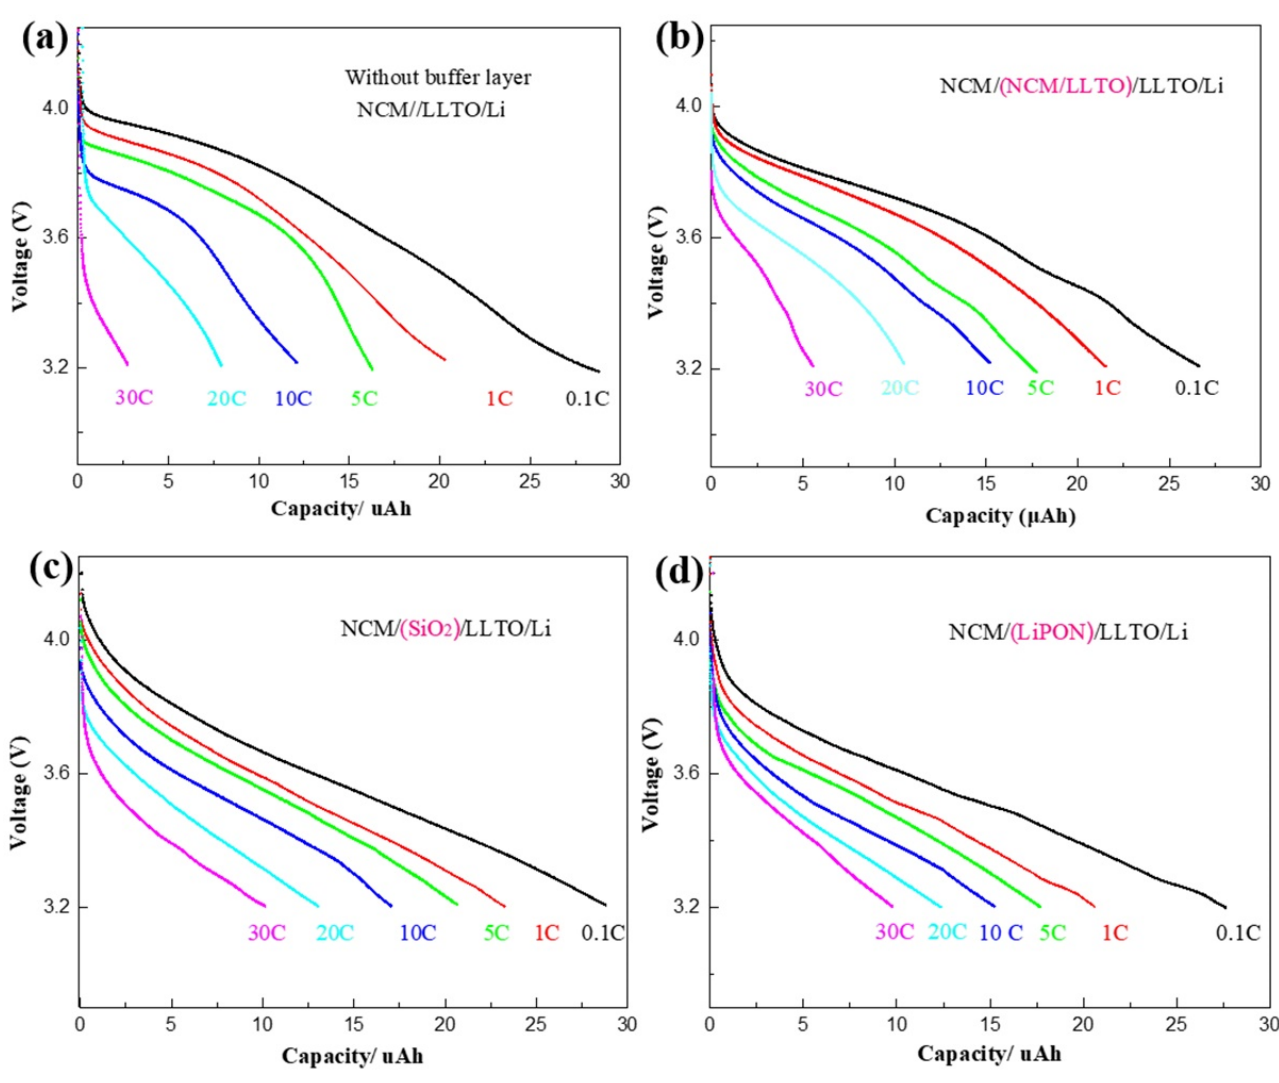
Figure 3. Rate characteristics of battery with different buffer layer: ( a ) NCM/LLTO, ( b ) NCM/(LLTO/NCM)/LLTO, ( c ) NCM/SiO 2 /LLTO, ( d ) NCM/LiPON/LLTO.